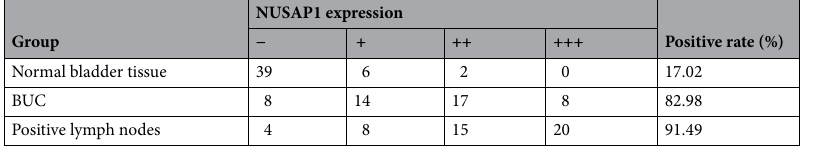
Table 2. NUSAP1 expression in BUC and normal bladder tissues. BUC vs. normal bladder tissue, P < 0.05; Positive lymph nodes vs. BUC, P < 0.05; Positive lymph nodes vs. normal bladder tissue, p <